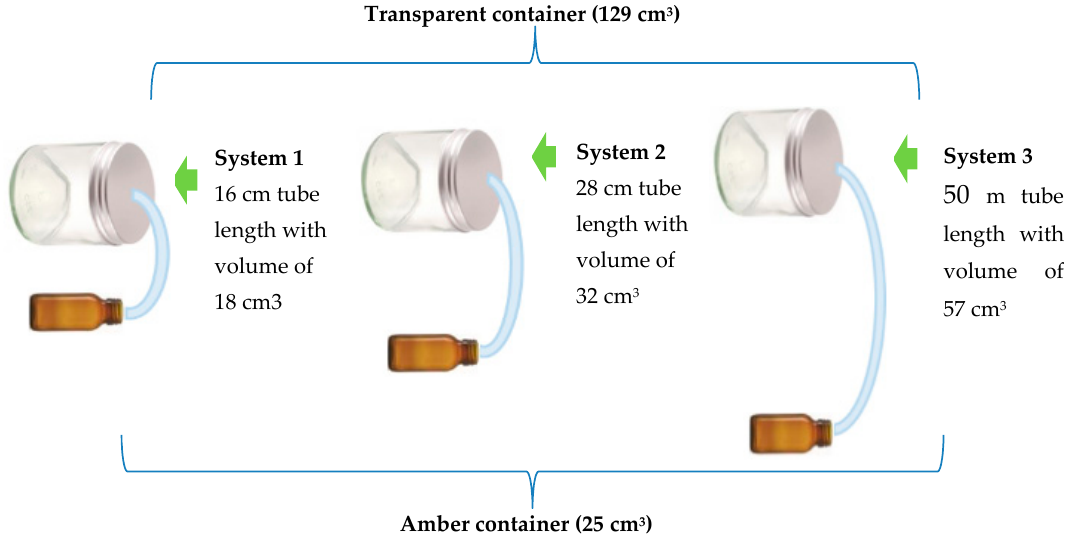
Figure 10. Diagram of the system used for testing the in vitro volatile effect of the de EO-agar-chitosan capsules.